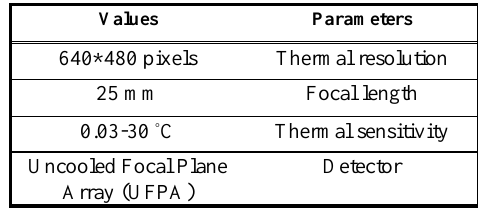
Table 1. Main characteristics of the used thermal camera